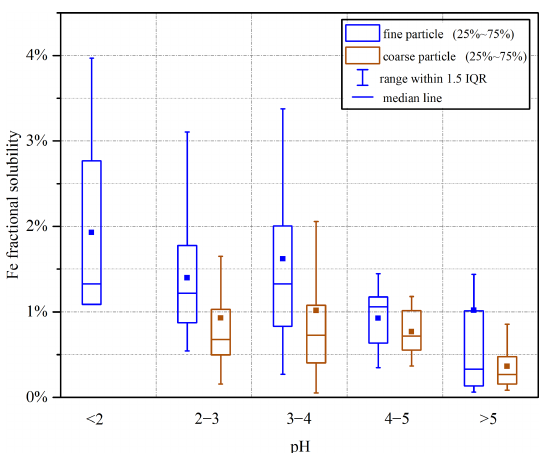
Figure 9. Fe solubility in different pH ranges for fine and coarse particles at